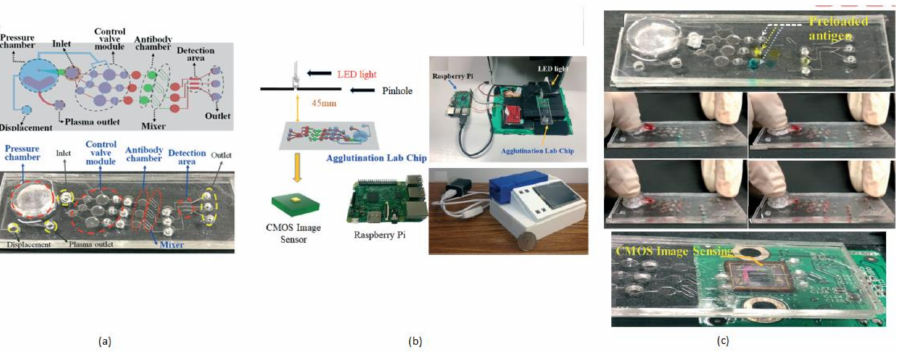
Figure 7. ( a ) Fingered powered agglutination lab chip. ( b ) Homemade CIS-based mini sensing system and finger powered agglutination lab chip ( c ) Antibodies were preloaded and pressing procedures, the agglutination lab chip is placed on CMOS image sensor of the homemade mini system. Figure adapted with permission from [14].